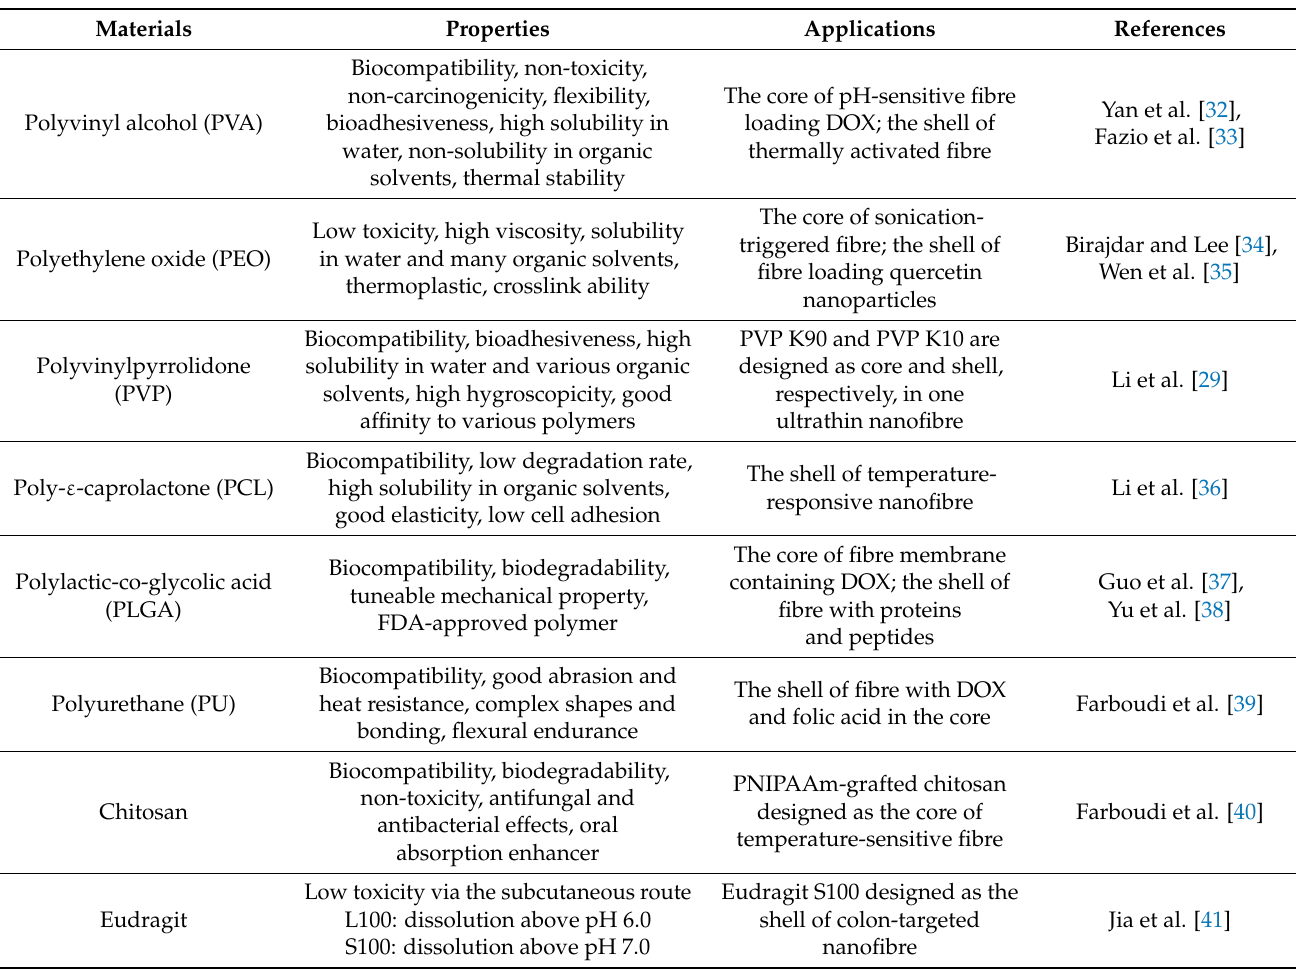
Table 1. Commonly used polymers as drug carrier materials for coaxial electrospun nanofibre drug delivery